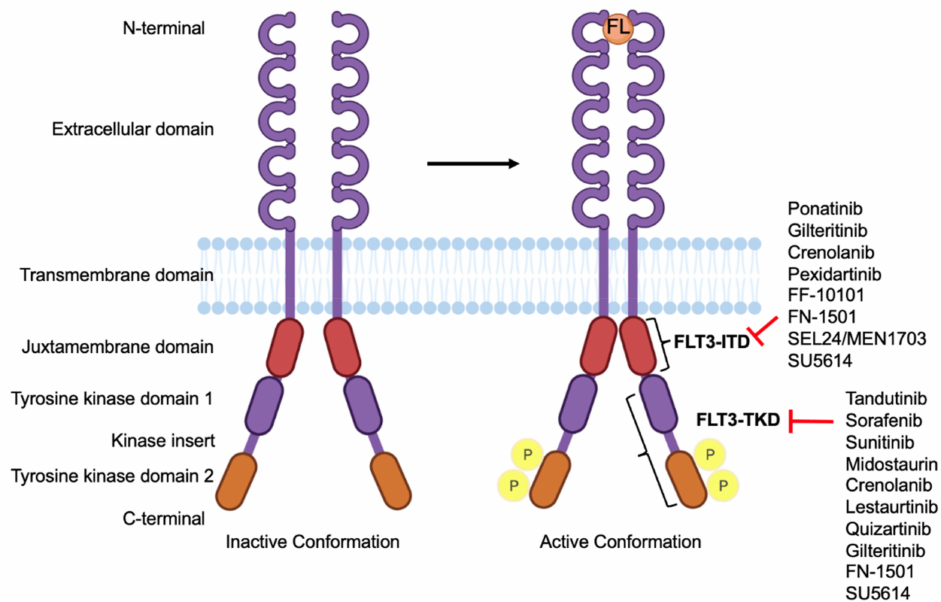
Figure 1. Structure of FLT3 and its drug targets. The structure of FLT3 in its inactive conformation which, upon binding to FLT3 ligand (FL), becomes active, resulting in its autophosphorylation. Different FLT3 inhibitors and their binding sites on their